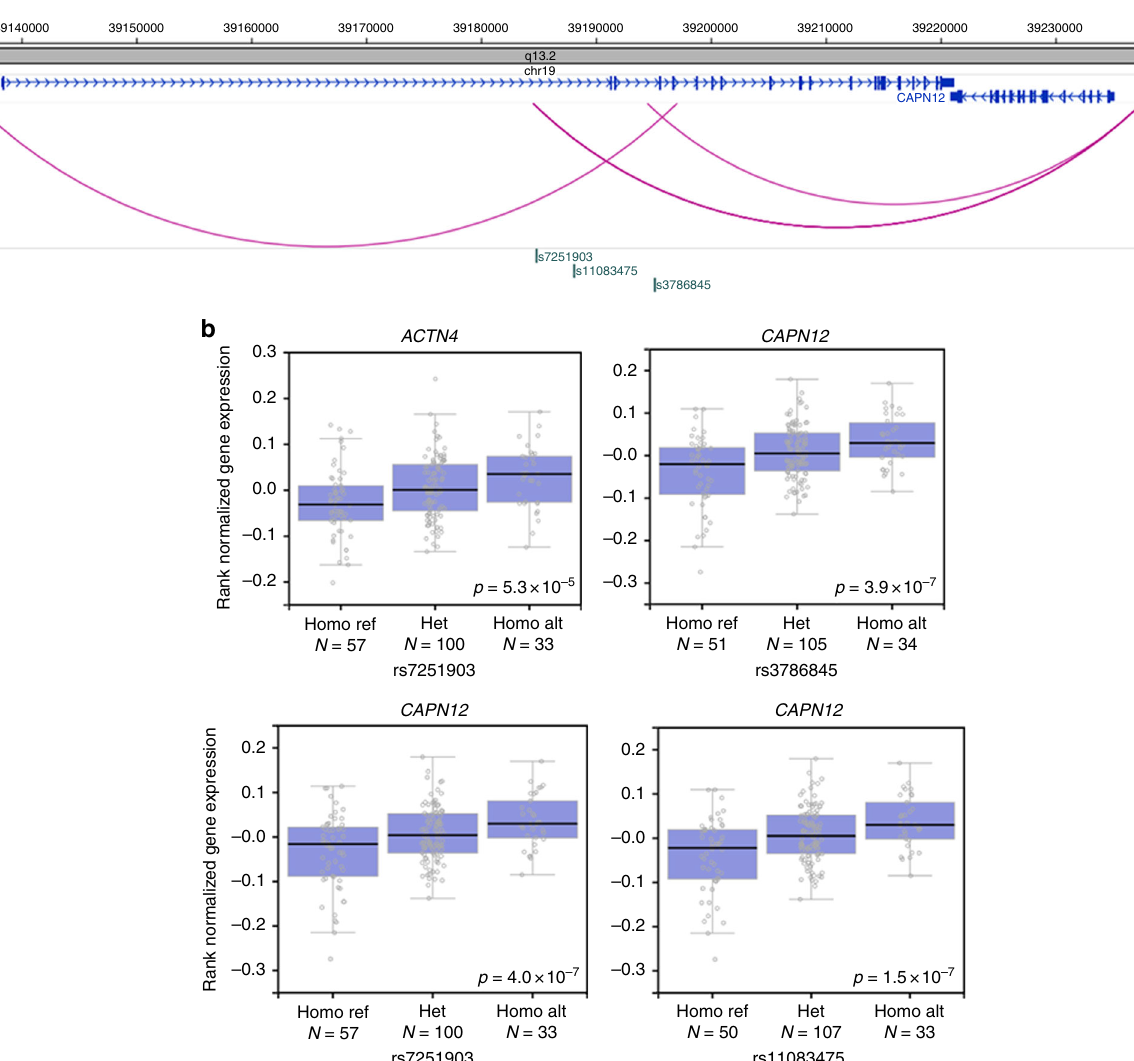
Fig. 6 Promoter interactions and eQTLs of ACTN4 – CAPN12 peak in CRD GWAS. a Genomic positions and promoter interactions of cPIR SNPs in ACTN4 – CAPN12 peak of CRD GWAS. b Left ventricular eQTL box plots (obtained from GTEx Portal V6p; https://www.gtexportal.org/) of cPIR SNPs and target genes in ACTN4 – CAPN12 peak of CRD GWAS. Gene expression levels were strati fi ed by the genotypes and the reference allele was associated with reduced expression levels. “ Homo Ref ” refers to the homozygous reference allele genotype; “ Het ” refers to the heterozygous genotype; and “ Homo Alt ” refers to the homozygous alternate allele